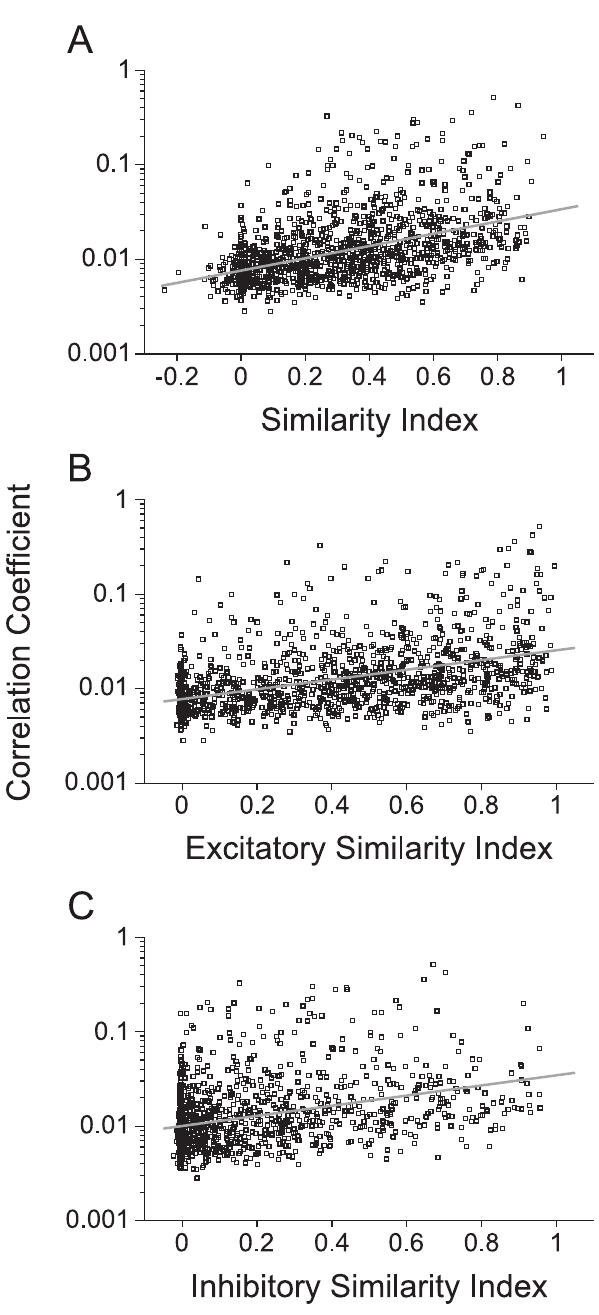
Figure 12. Correlation coefficient versus STRF similarity for monosynaptic functionally connected neurons (N=1203 pairs). STRF similarity was computed for (A) the full STRF (r=0.444, p , 0.01, t- test), (B) the excitatory subfields of the STRF (r=0.434, p , 0.01, t-test), and (C) the inhibitory subfields of the STRF (r=0.348, p , 0.01, t-test). doi:10.1371/journal.pone.0009521.g012 even more compelling. The correlation coefficient was calculated with respect to the peak in the correlation function. Since we required two consecutive significant bins, it is unlikely that this metric is biased by random fluctuations. Also, since we removed background activity, the halfwidth represents an estimate of the driven temporal overlap for the responsiveness of pairs of neurons. Thus, the halfwidth metric is not an overestimate of the duration of temporal interactions.